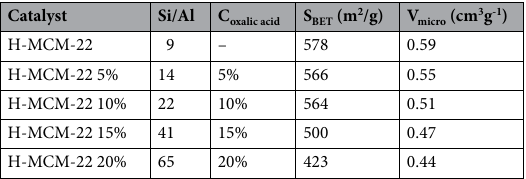
Table 1. BET surface area analysis of H-MCM-22, H-MCM-22 5%, H-MCM-22 10%, H-MCM-22 15%, and H-MCM-22 20%.